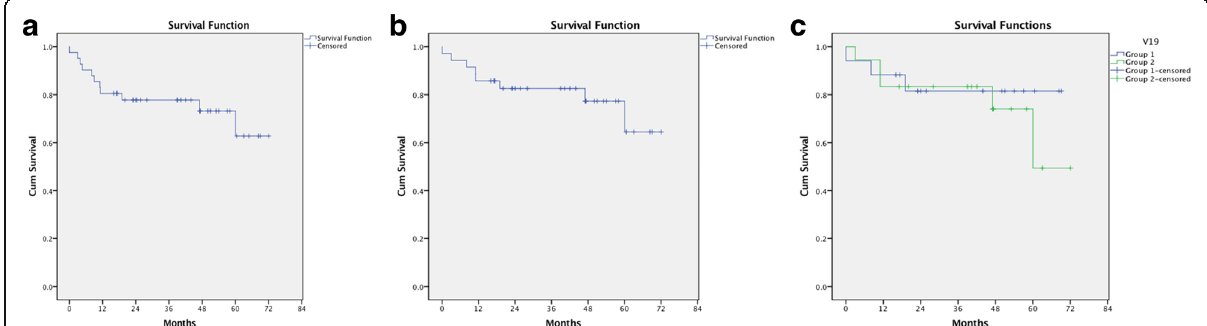
Fig. 1 Kaplan-Meier Survival curves showing: ( a ) time to flare-up for patients with post ATT followup data, ( b ) time to flare-up for patients with both pre and post ATT data and ( c ) time to flare-up for patients in group 1 and group 2 where group 1 were treated with ATT within 8 months of their first uveitis attack and group 2 were treated more than 8 months after their first uveitis